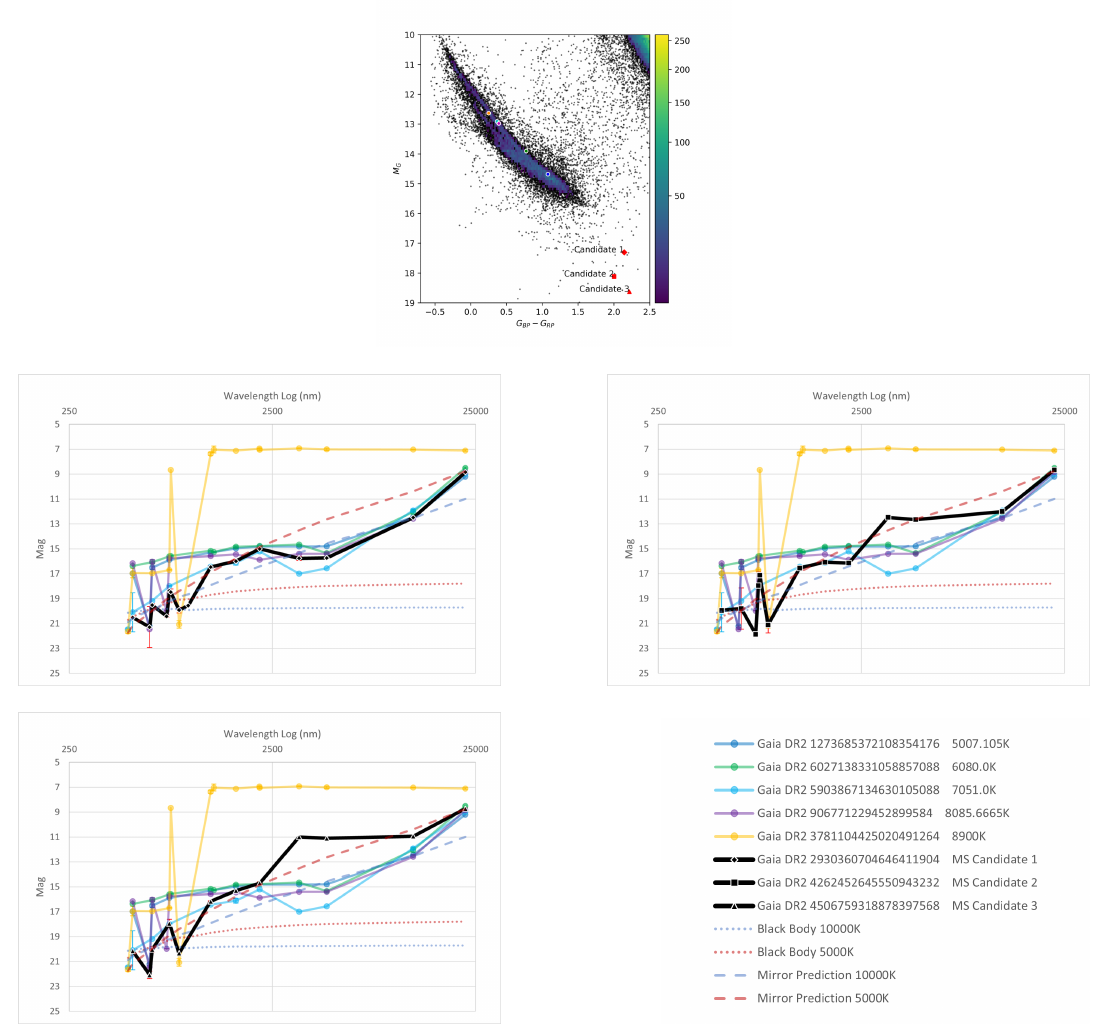
Figure 6. HR-diagram shows white dwarf region and mirror star candidates #1, #2, #3. Also marked are 5 randomly selected comparison white dwarfs with temperatures from 5000K– 9000K. Plots show pseudo-spectra of mirror star candidates (black solid) and comparison white dwarfs (coloured solid), using magnitude measurements in different stellar survey passbands. The dashed/dotted opaque curves are the mirror star / blackbody theoretical expectations from figure 5 for